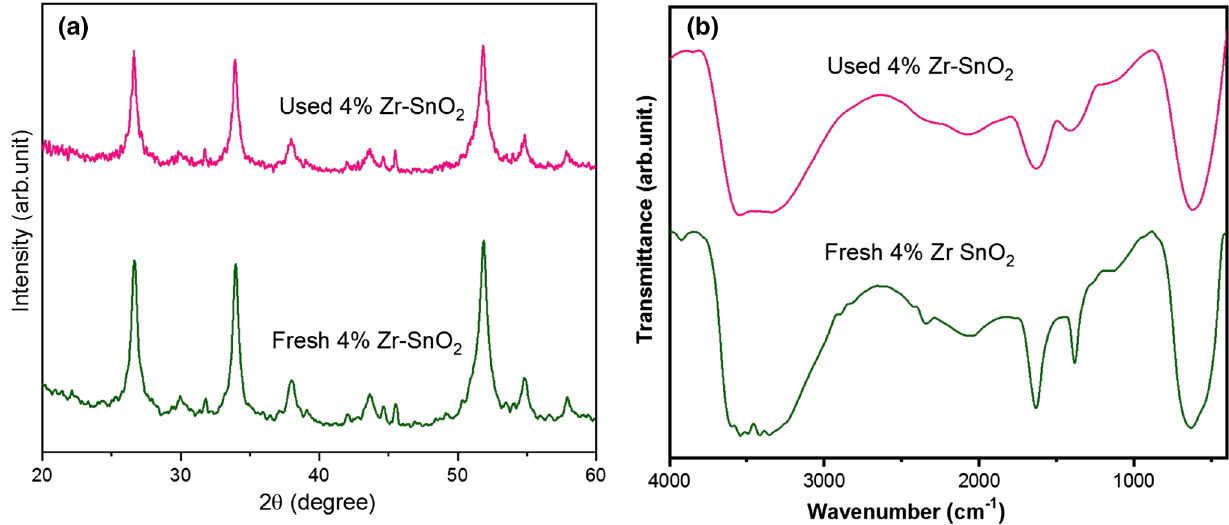
Fig. 12 XRD pattern and FTIR spectra for 4% Zr-doped SnO